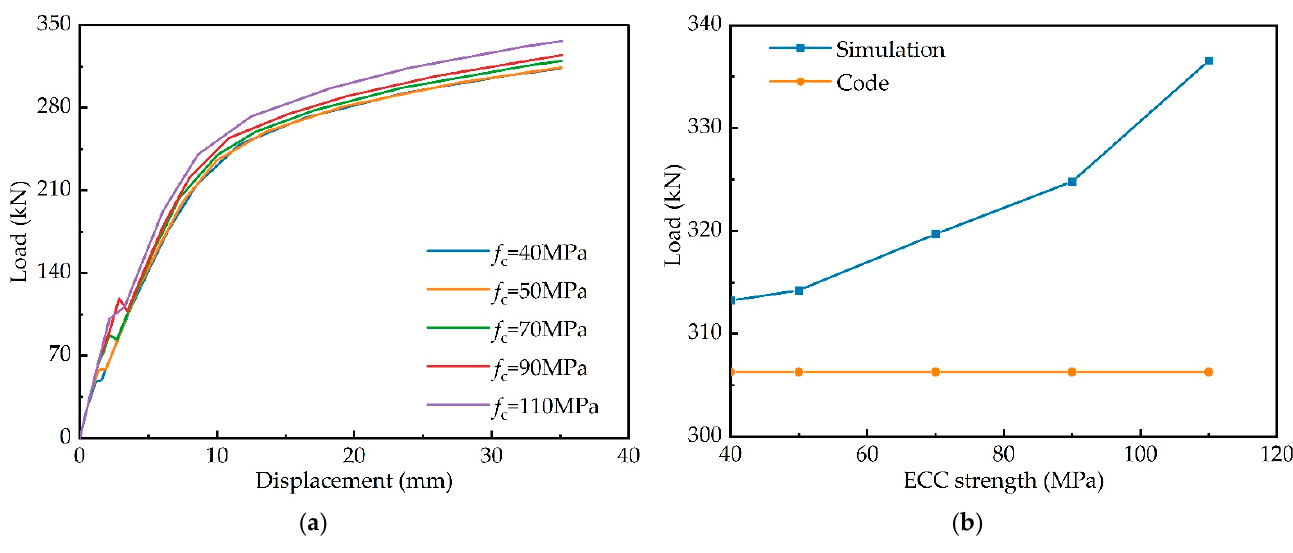
Figure 14. Effects of ECC strength: ( a ) load–deflection curves; ( b ) comparison of flexural bearing capacity.